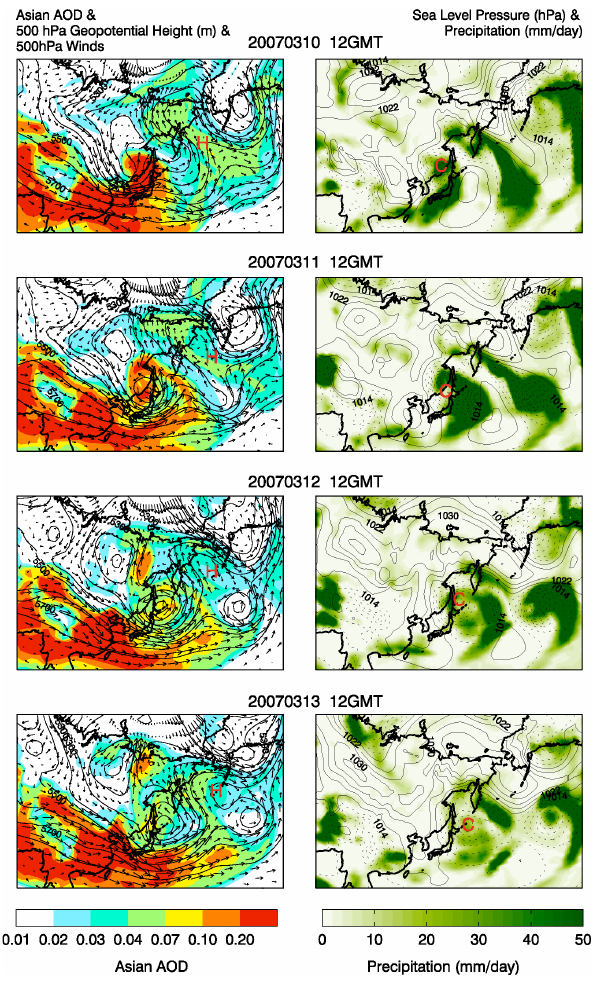
Figure 7. Synoptic situation during the initial stages of the export event of March 12-19, 2007. Conventions are the same Fig. 7. Synoptic situation during the initial stages of the export as in Figure 3. event of 12–19 March 2007. Conventions are the same as in Fig.